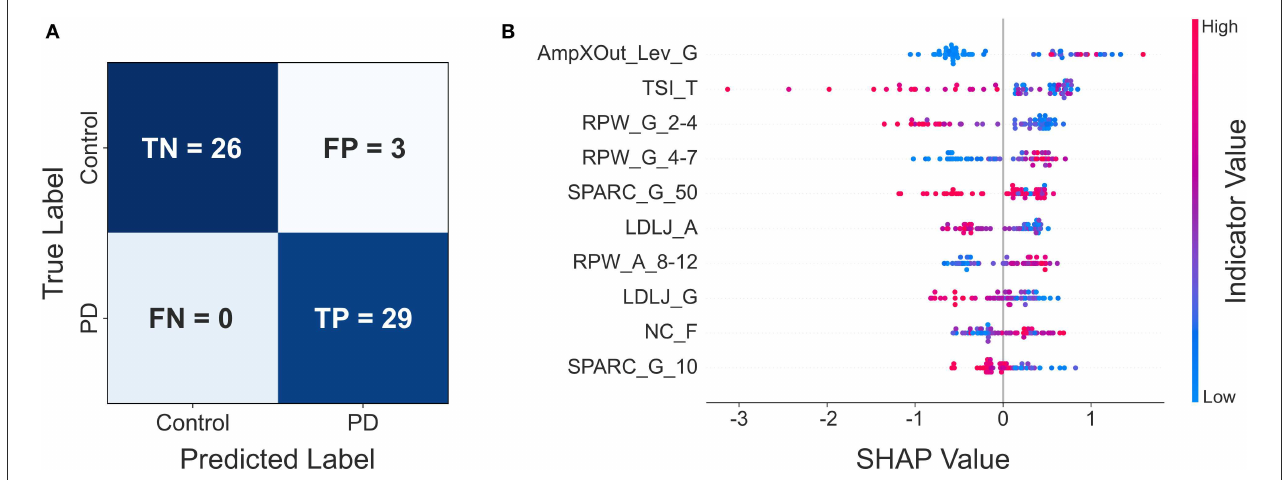
Figure 1, Control A was one of the misclassified subjects (false positive) by the best model, while Control B was correctly